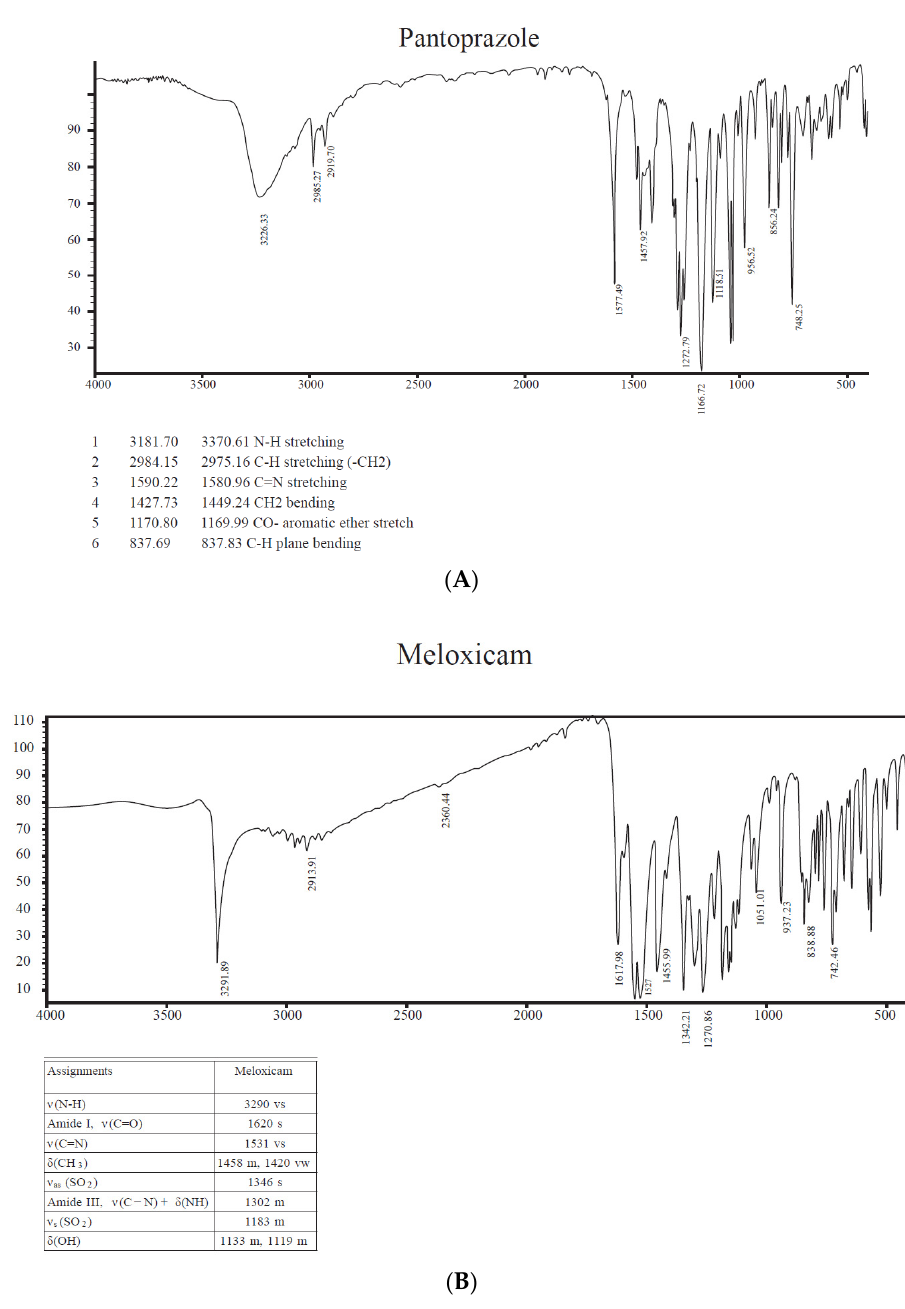
Figure 3. ( A ) FTIR spectra of pantoprazole. ( B ) FTIR spectra of